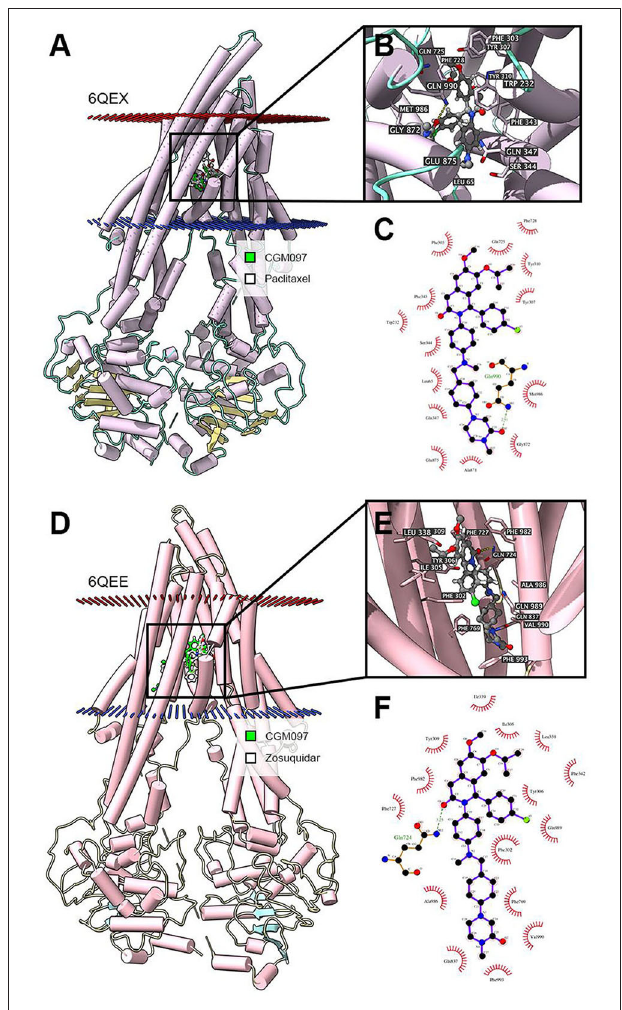
FIGURE 6 | Interaction between NVP-CGM097 and human ABCB1 protein. (A) Overview of paclitaxel and the best-scoring pose of NVP-CGM097 in the drug binding pocket of ABCB1 protein (6QEX). Cytoplasm membrane was depicted as dotted planes where red or blue plane indicate extracellular or intracellular side, respectively. ABCB1 was displayed as colored tubes and ribbons. NVP-CGM097 and paclitaxel were displayed as colored sticks. Carbon: lime green (NVP-CGM097) or white (paclitaxel); oxygen: red; nitrogen: blue; chloride: green. (B) Details of interactions between NVP-CGM097 and ABCB1 (6QEX) binding pocket. ABCB1 was displayed as purple tubes. Important residues were displayed as colored sticks (carbon: purple; oxygen: red; nitrogen: blue). NVP-CGM097 was displayed as colored sticks (carbon: gray; oxygen: red; nitrogen: blue; chloride: green). Hydrogen bonds were displayed as yellow dash lines. (C) 2D NVP-CGM097-P-gp (6QEX) interaction. Important amino acids were displayed as red arcs, and green dash line with number indicates hydrogen bond with bond length. Carbon: black; oxygen: red; nitrogen: blue; chloride: green. (D) Overview of zosuquidar and the best-scoring pose of NVP-CGM097 in the drug binding pocket of ABCB1 protein (6QEE). (E) Details of interactions between NVP-CGM097 and ABCB1 (6QEE) binding pocket. Hydrogen bonds were displayed as yellow dash lines. (F) 2D NVP-CGM097-P-gp (6QEE) interaction. Color codes are same as (C) .